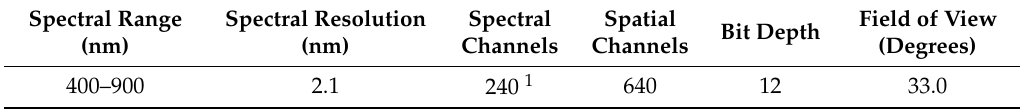
Table 1. Specifications of the hyperspectral imaging